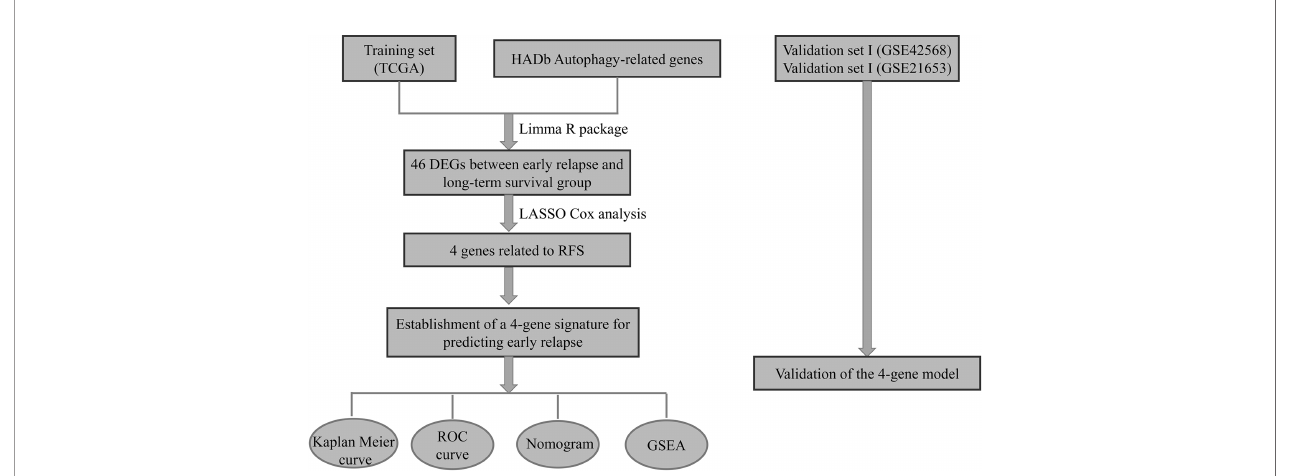
FIGURE 1 | The autophagy-related 4-gene signature selection and validation